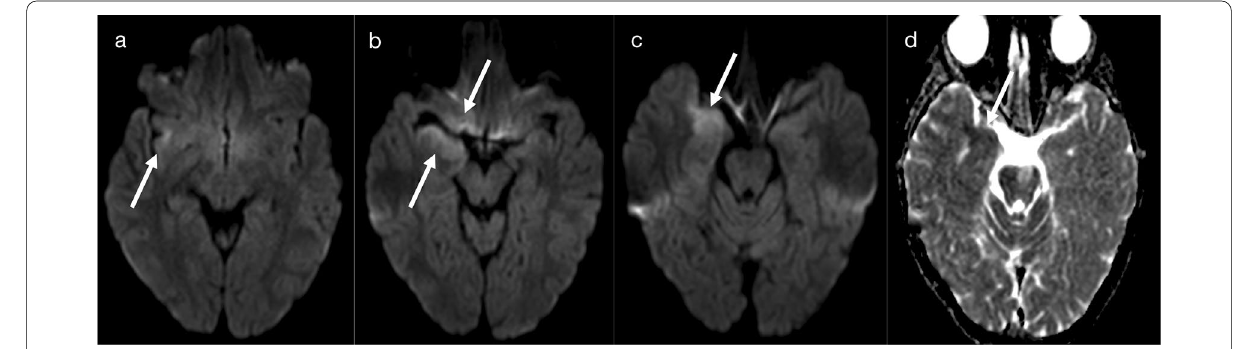
Fig. 6 Restricted diffusion in supratentorial grey matter—mesial temporal lobe (Pattern 2B). 7‑year‑old child with headache, fluctuating consciousness and tonic–clonic seizures. CSF was positive for HSV‑1. DWI ( a – c ) and ADC map ( d ) demonstrated asymmetric signal abnormalities predominantly involving the right mesial temporal lobe (amygdala and uncus), anterior perforated substance and insular cortex (arrows), as would be typical for HSV encephalitis in adults